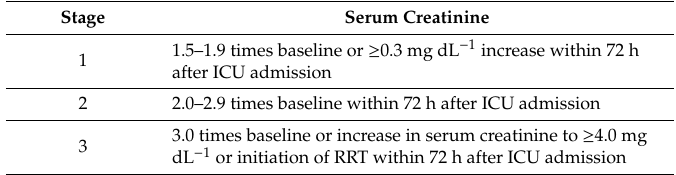
Table A1. Staging of postoperative acute kidney injury (KDIGO).